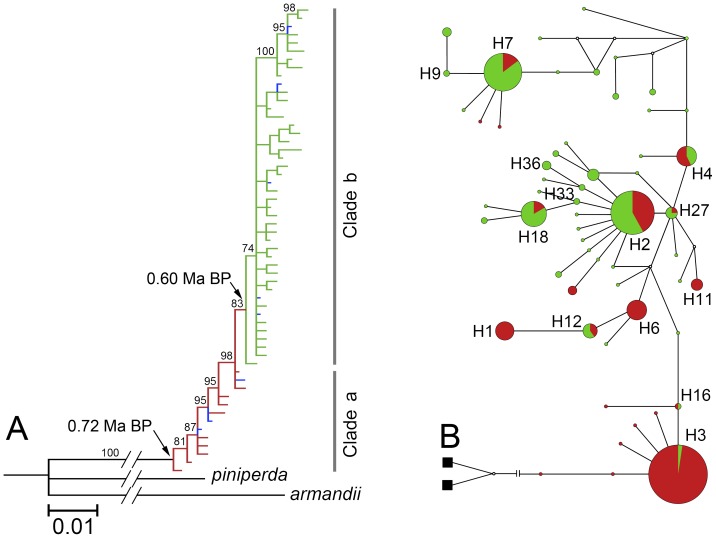
Population genetic structures of T. yunnanensis: (A) the Bayesian Inference (BI) tree of 57 haplotypes and outgroups (black terminal) with bootstrap values over 50 (see Fig. S2 for complete haplotype numbers and interior branch bootstrap values) and (B) the median-joining haplotype network denoted with shared haplotypes, the coloration of all three charts were in accordance with the group assignment of both of the SAMOVA analyses, red: Group 1, green: Group 2, blue: admixed.